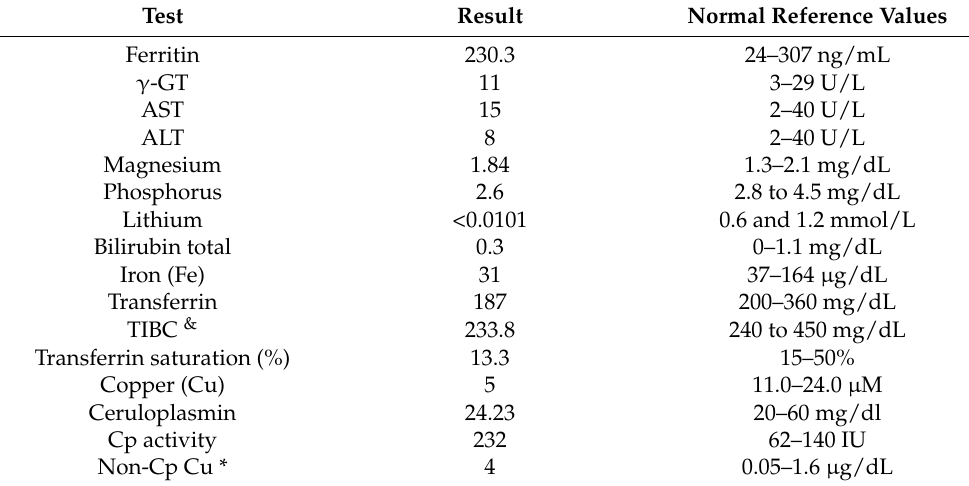
Table 6. Biochemical features of the CuAD